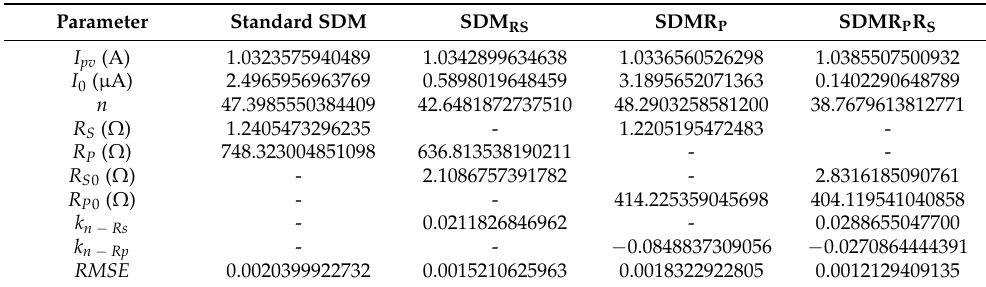
Table 2. Estimated parameters value for the proposed equivalent circuits for the investigated Photowatt-PWP201 module.